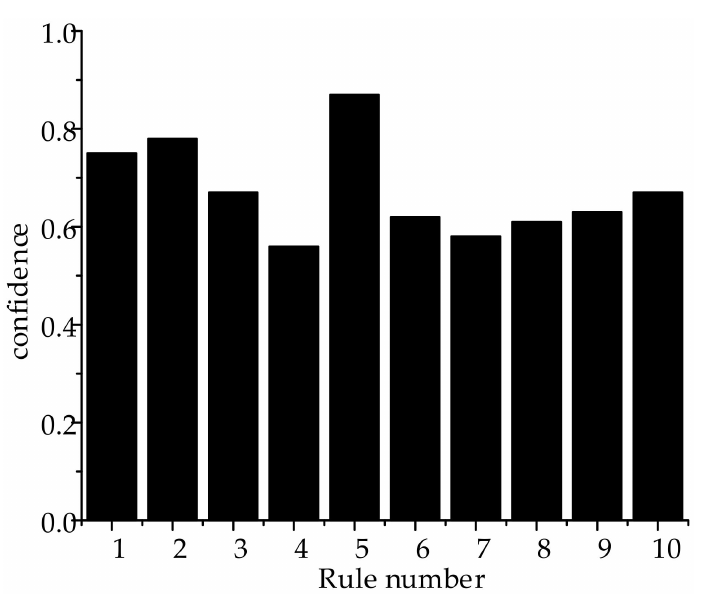
Figure 7. Association rules’